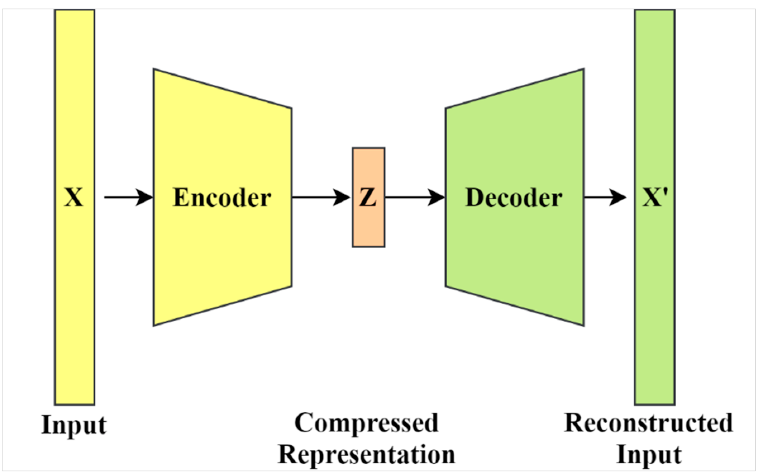
Figure 1. The general architecture of autoencoders.